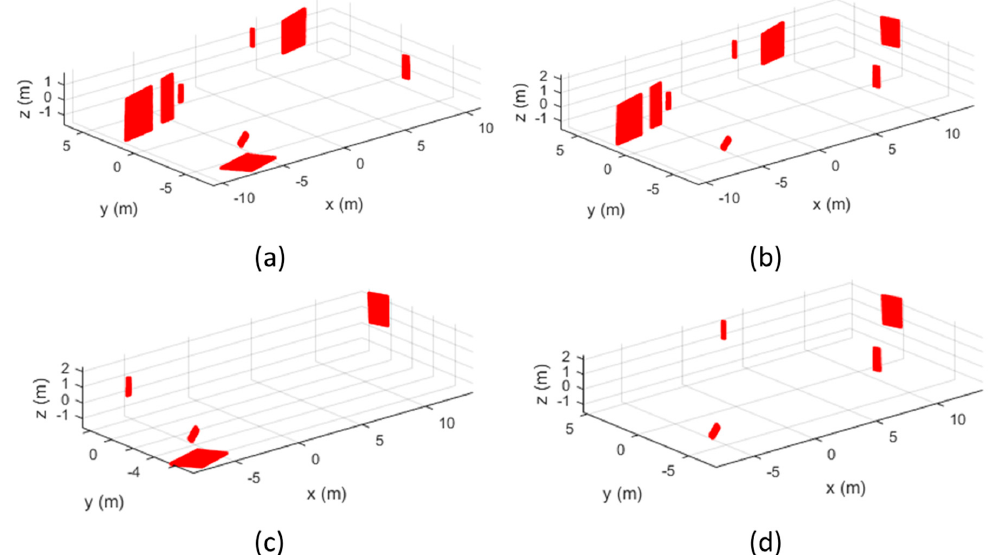
Figure 12. Example of good and bad geometries of control planes: ( a ) successful case with eight planes; ( b ) failed case with eight planes; ( c ) successful case with four planes; ( b ) failed case with four planes.